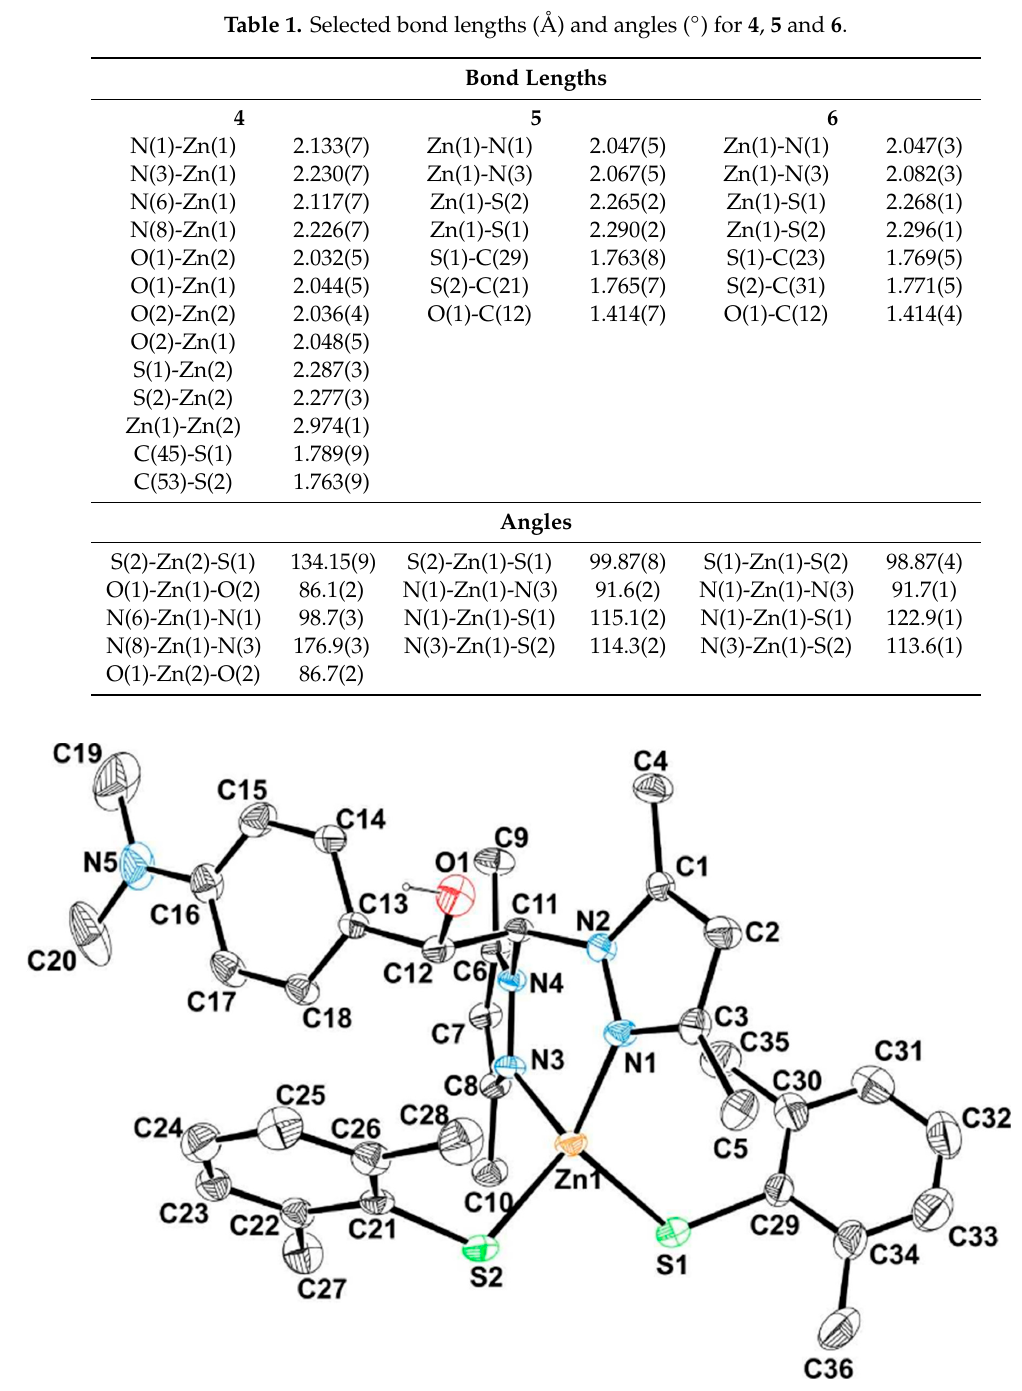
Figure 2. ORTEP view of the S enantiomer of [Zn(2,6-Me 2 C 6 H 3 S) 2 (Hbpzampe)] ( 5 ). Hydrogen atoms have been omitted for clarity. Thermal ellipsoids are drawn at the 30% probability level.